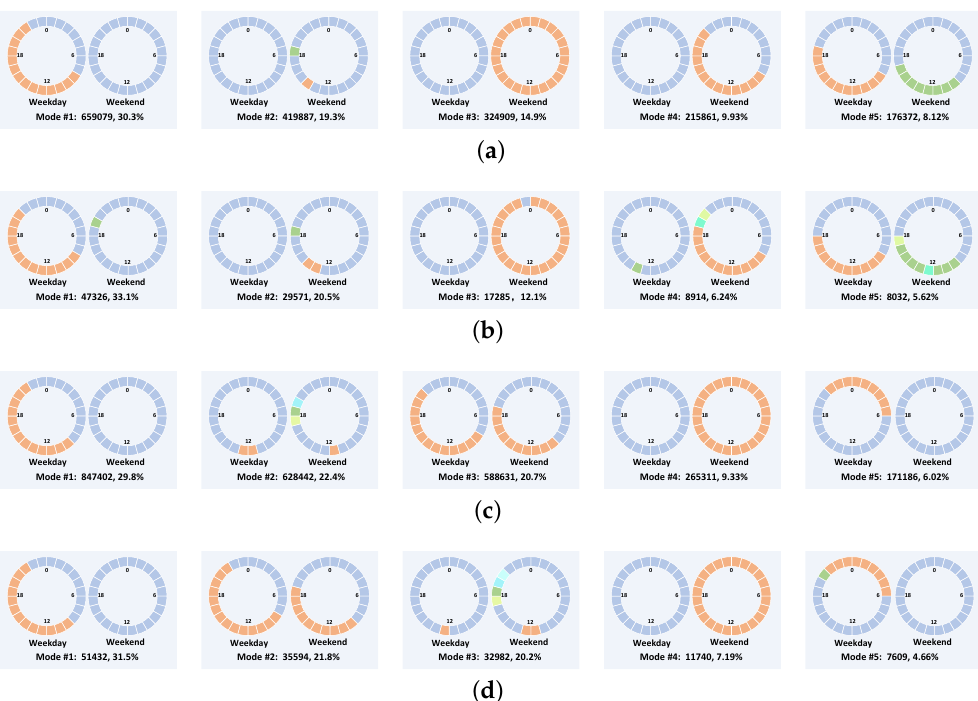
Figure 8. Visualization of popular temporal modes. ( a – d ) correspond to 5 main modes in T 1 and T 2 , from Shanghai and Beijing, respectively. Each mode is composed of two annular representations, for weekday patterns and weekend patterns. An annular representation contains 24 time slices, aiming to describe users’ traffic patterns on a typical day. Time slices with the same colors mean that the user tends to stay in the same location during these periods. ( a ) Five main popular temporal modes in Shanghai ( T 1 ); ( b ) five main popular temporal modes in Shanghai ( T 2 ); ( c ) five main popular temporal modes in Beijing ( T 1 ); ( d ) five main popular temporal modes in Beijing ( T 2